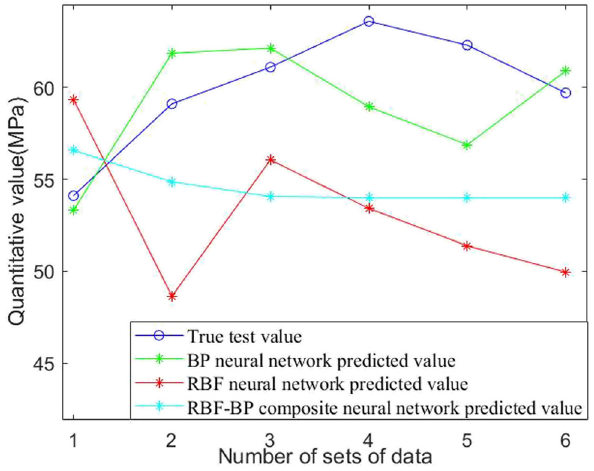
Figure 4: Compressive strength predicted results of three neural